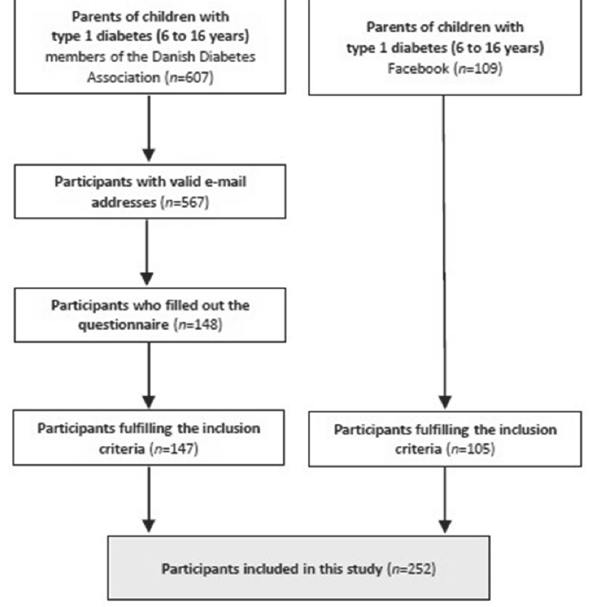
Figure 1. Flow chart of study participants.